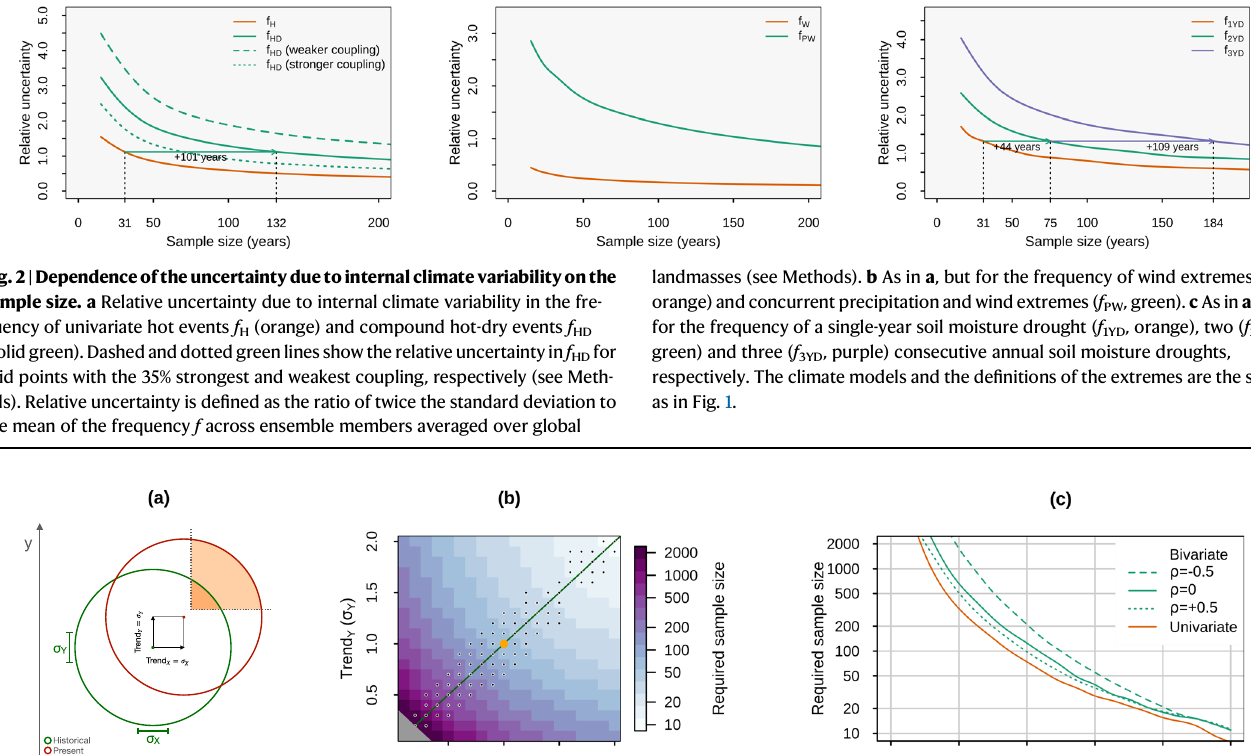
bottom-left indicates a required sample size larger than the values in the palette. The large orange dot indicates the combination of trends displayed in a . Stippling indicatescombinationsofTrend Y andTrend X forwhichattributingthecompound event requires a larger sample size than that needed for attributing any of the underlying univariate events (elsewhere compound attribution requires a sample size in between that needed for the two univariate events in isolation). c Sample size required for attributing any of the two univariate events (orange), and the compound event (green) assuming equal forced trends for both drivers and dif- ferent constant correlation ( ρ ) between the drivers (see legend).